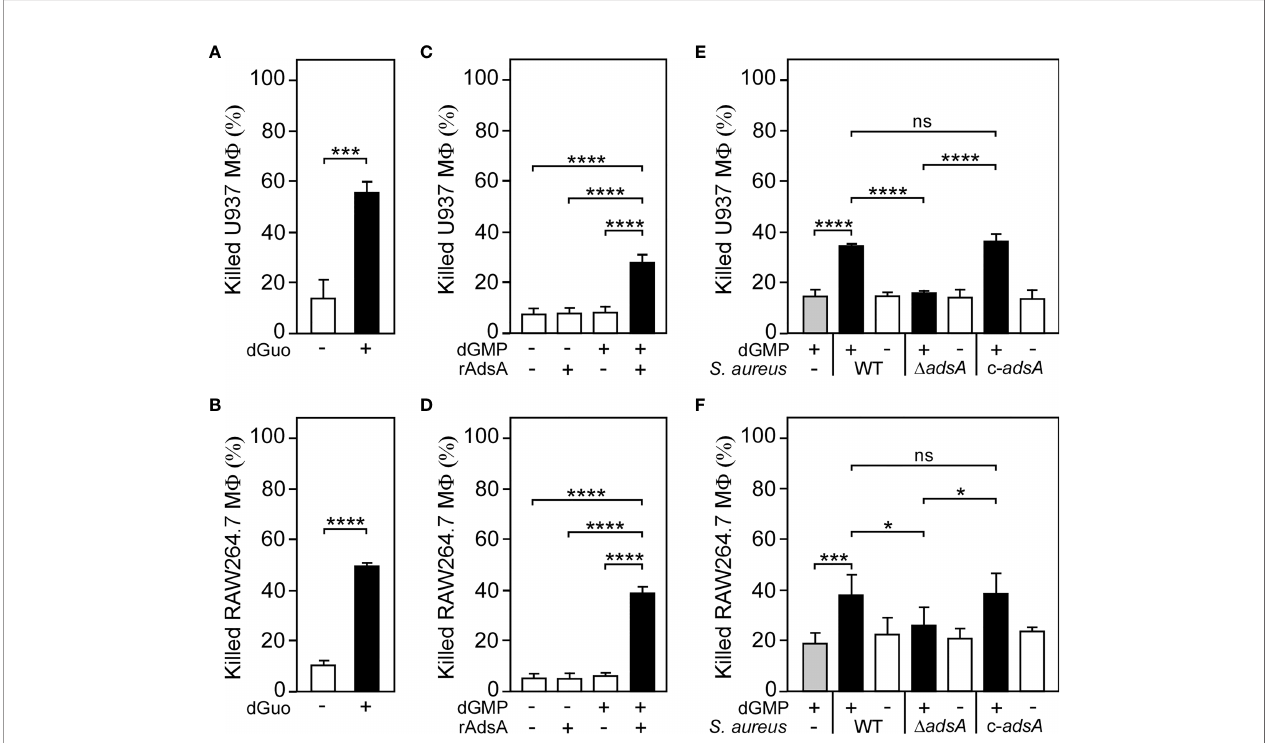
FIGURE 2 | S. aureus generates deoxyguanosine to kill phagocytes. (A, B) Survival rates of human U937-derived macrophages (M Ф ) (A) or murine RAW264.7 M Ф (B) exposed to dGuo (+) or left untreated (-). (C, D) Survival rates of U937-derived M F (C) or murine RAW264.7 M Ф (D) exposed to rAdsA-derived dGuo. rAdsA was incubated with dGMP and reaction products containing dGuo were used to kill phagocytes. Controls lacked rAdsA or dGMP or included reaction buffer only as indicated with + and − symbols. (E, F) Survival of U937-derived M F (E) or murine RAW264.7 M Ф (F) after treatment with culture medium (RPMI 1640) that had been conditioned by incubation with either wild-type (WT) S. aureus Newman, its adsA mutant ( D adsA ), or the complemented adsA variant (c- adsA ) in the presence (black bars) or absence (white bars) of dGMP. Controls included culture medium that had been conditioned by incubation with dGMP only (gray bars). 160 µM (A) or 320 µM (B) of dGuo was used to treat the cells. Cell survival rates were analyzed 24 h (A, C – E) or 48 h (B, F) post-treatment. Data are the mean (± standard deviation [SD]) values from at least three independent determinations. Statistically signi fi cant differences were analyzed by a two-tailed Student ’ s t-test (A, B) or with one-way analysis of variance (ANOVA) and Tukey ’ s multiple-comparison test (C – F) ; ns, not signi fi cant ( P ≥ 0.05); * P < 0.05; *** P < 0.001; **** P <